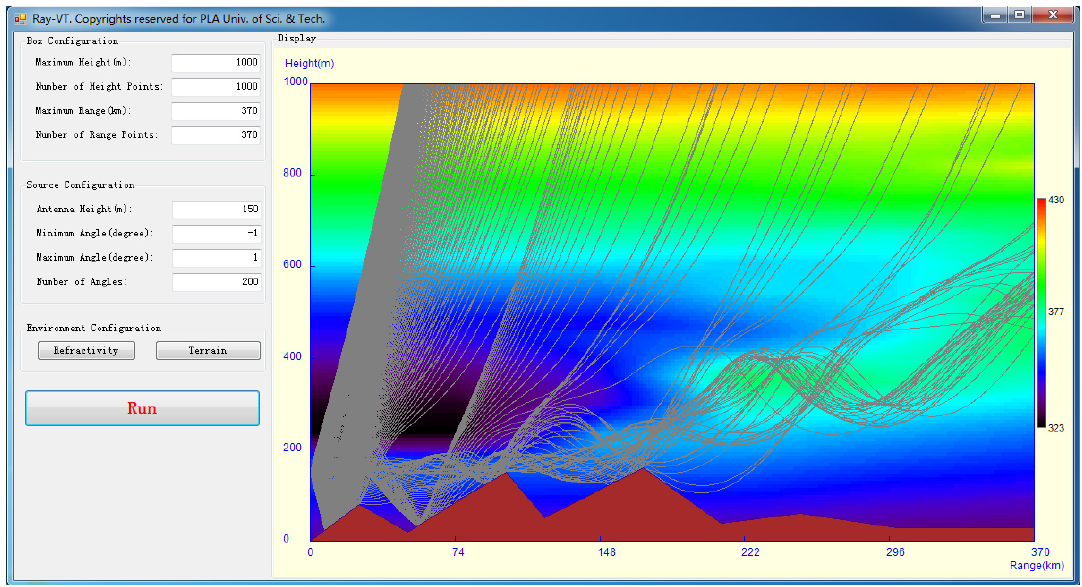
Figure 6. GUI of the Ray-VT for rays propagating through the refractivity fields measured between a Pt. Loma and Guadalupe Island of 12 March 1948.